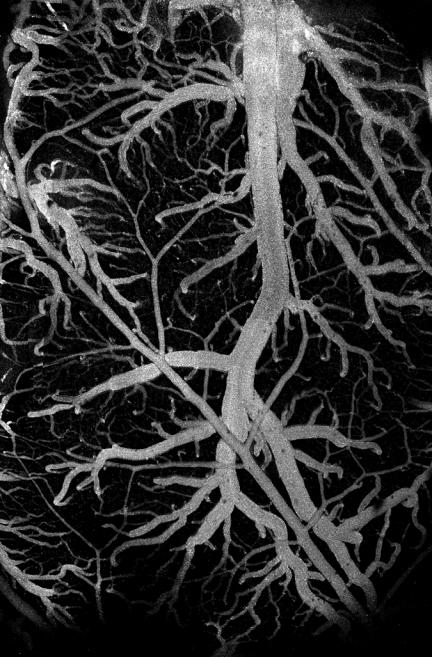
The surface arteriole communicating network in the rat